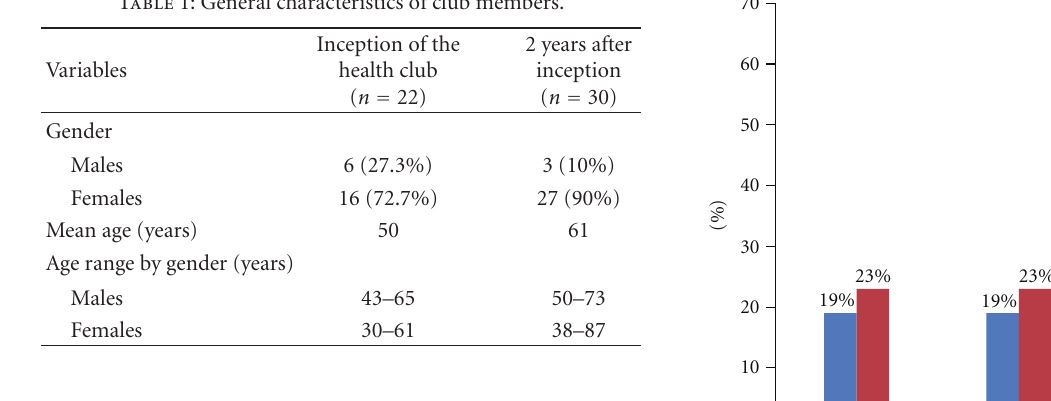
Table 2: Anthropometric measurements and mean values of the participants.